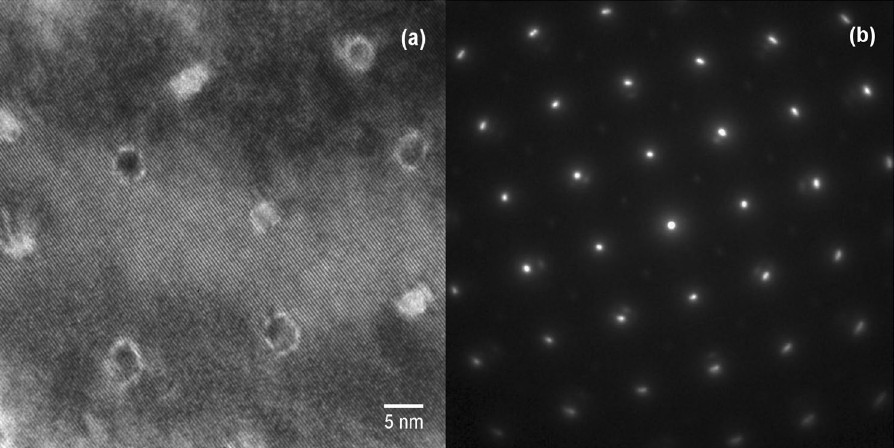
Figure 4. TEM plan-view analysis: ( a ) microstructure and ( b ) plan-view electron diffraction pattern, revealing BZO nanorods with ~3.5 and 17.5 nm diameter and spacing, respectively, and sharp in-plane